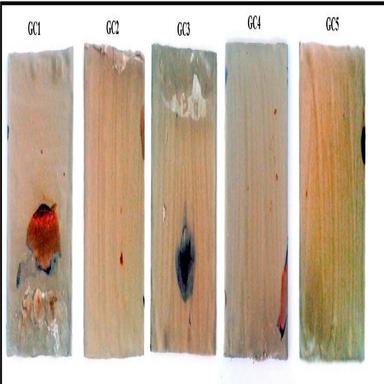
Onset of corrosion after 168 h on mild steel substrate coated with different hybrid geopolymeric compositions immersed in 3.5% NaCl solution.